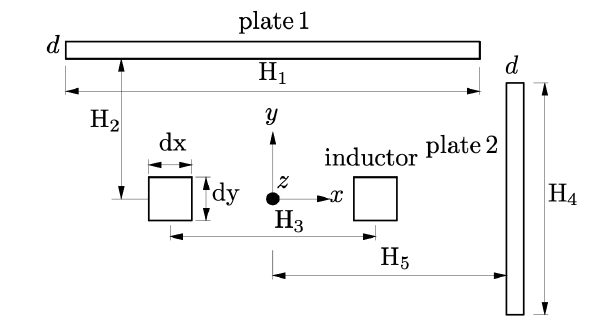
Fig. 1. 2-D geometry of two thin plates and an inductor (plate1 and plate2) ( H 1 = 120mm, H 2 = H 3 = 45mm, H 4 = 80mm, H 5 = 67.5mm, d = 5mm, dx = dy =